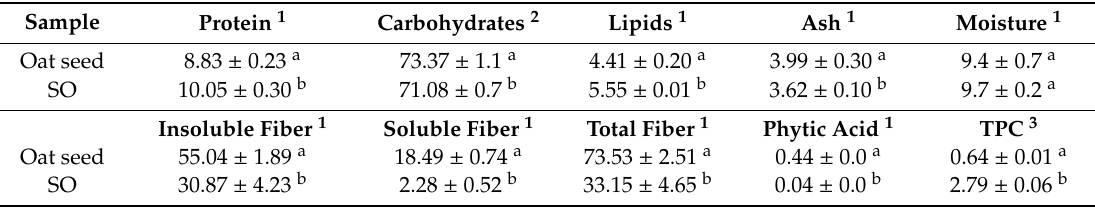
Table 1. Chemical analysis, insoluble and soluble dietary fiber, phytic acid, and total phenolic contents in oat seed and SO (Turquesa variety) after five days of germination in darkness at 25 ◦ C / 60% relative humidity